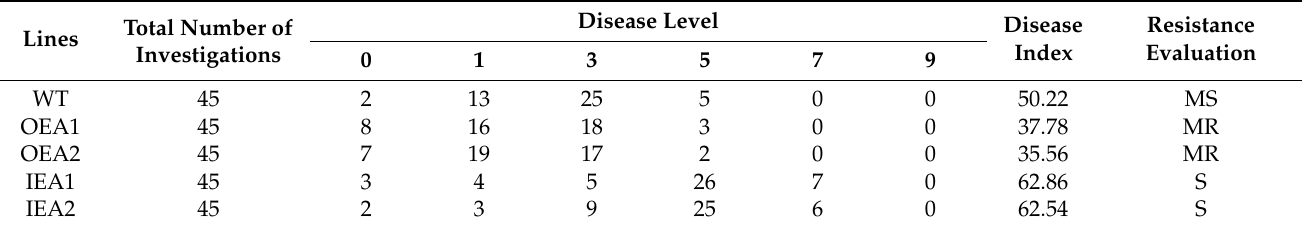
Table 1. Statistics of Cercospora sojina